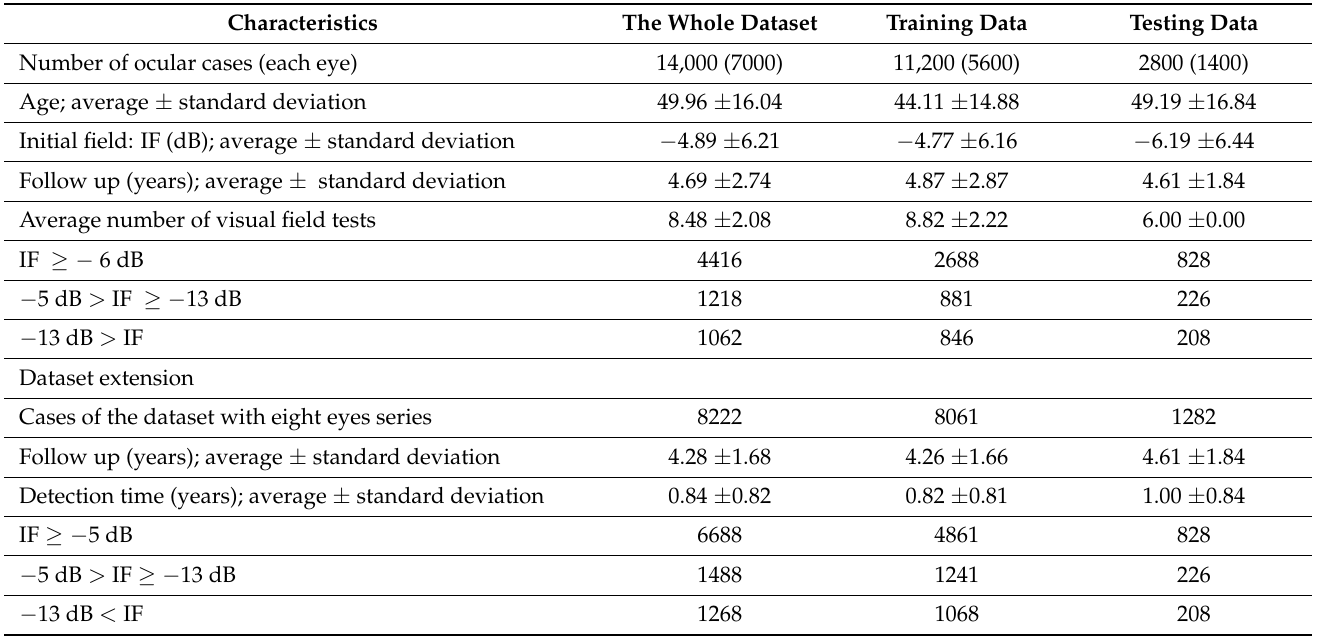
Table 2. Characteristics of the